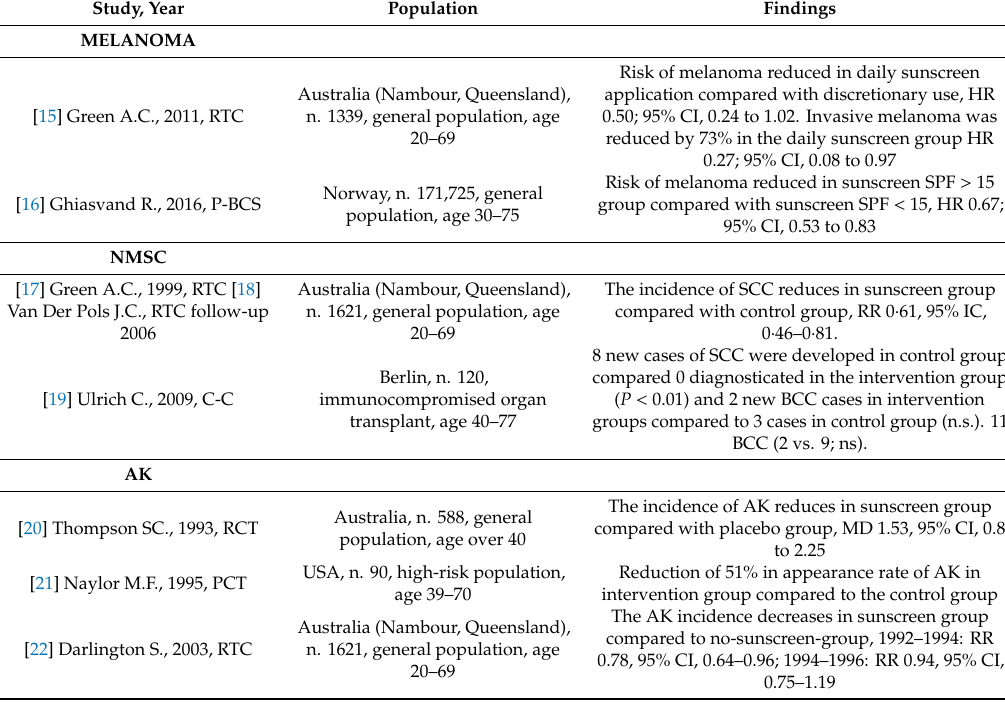
Table 1. Study’s findings. RTC: randomized controlled trial, P-BCS: population-based cohort study, C-C: case-control, CT: controlled trial, CI: confidence interval, HR: hazard ratio, RR: relative risk, MD: mean di ff erence, PCT: prospective controlled